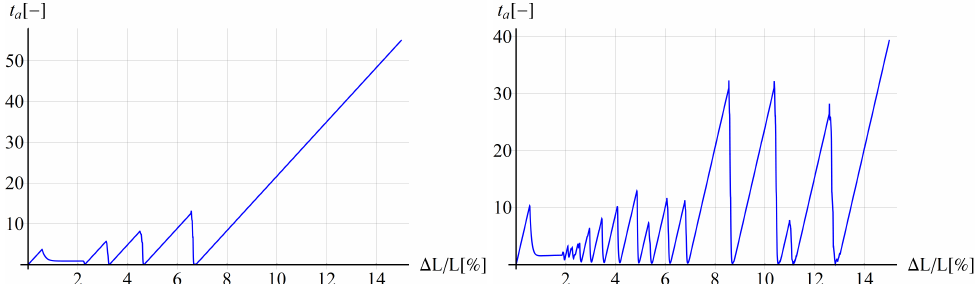
Figure 2. Strain ageing time vs. longitudinal displacement for rod benchmark at the right end of the sample ( left ) and for the bone-shape plate in tension at the centre of the sample ( right ).